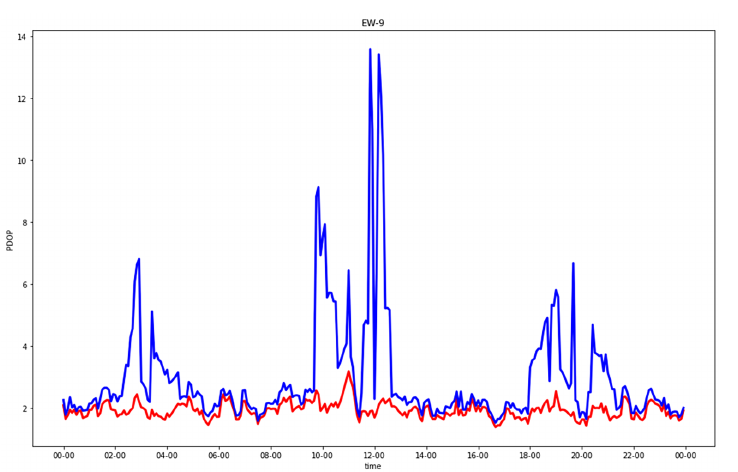
Figure 5. PDOP in east-west residential street for GNSS-alone (blue) compared with GNSS + five 5G stations (red).